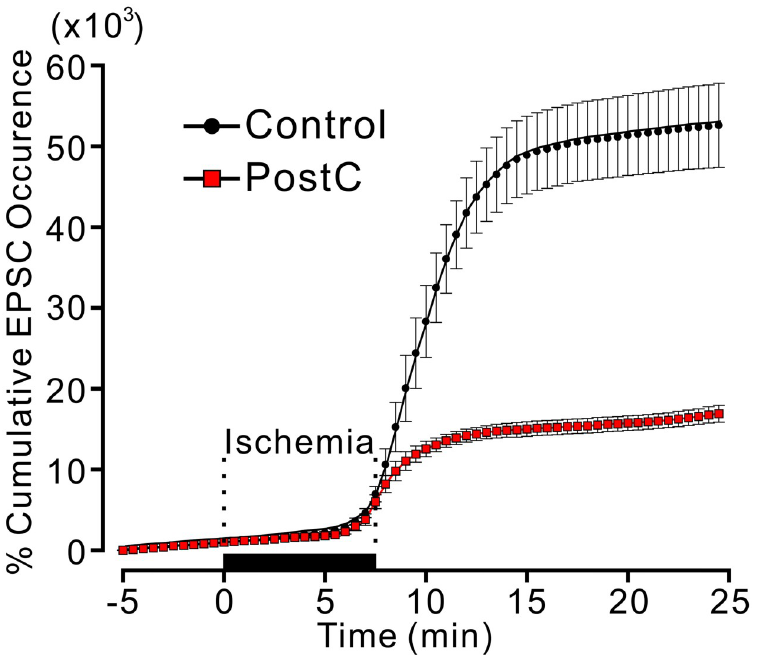
Fig 4. Time course of cumulative EPSC occurrence for Control and PostC groups. In each line plot, the marker and error bar show mean and standard error of mean (SEM), respectively. The cumulative value of EPSC occurrence is expressed in percent of the total number of EPSC occurrence during pre-ischemic 5 min. The large majority of EPSCs occurred during 5 min after the reperfusion for the both groups.